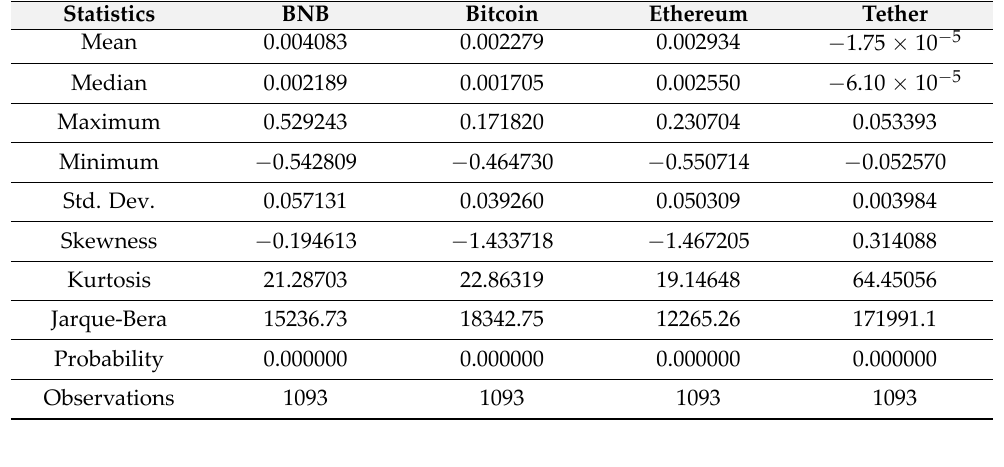
Table 1. Summary statistics of the Cryptocurrencies returns.